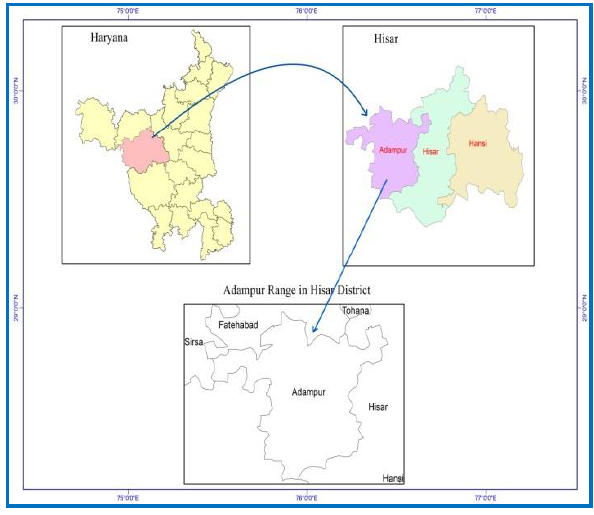
Figure 1. Location map of study area